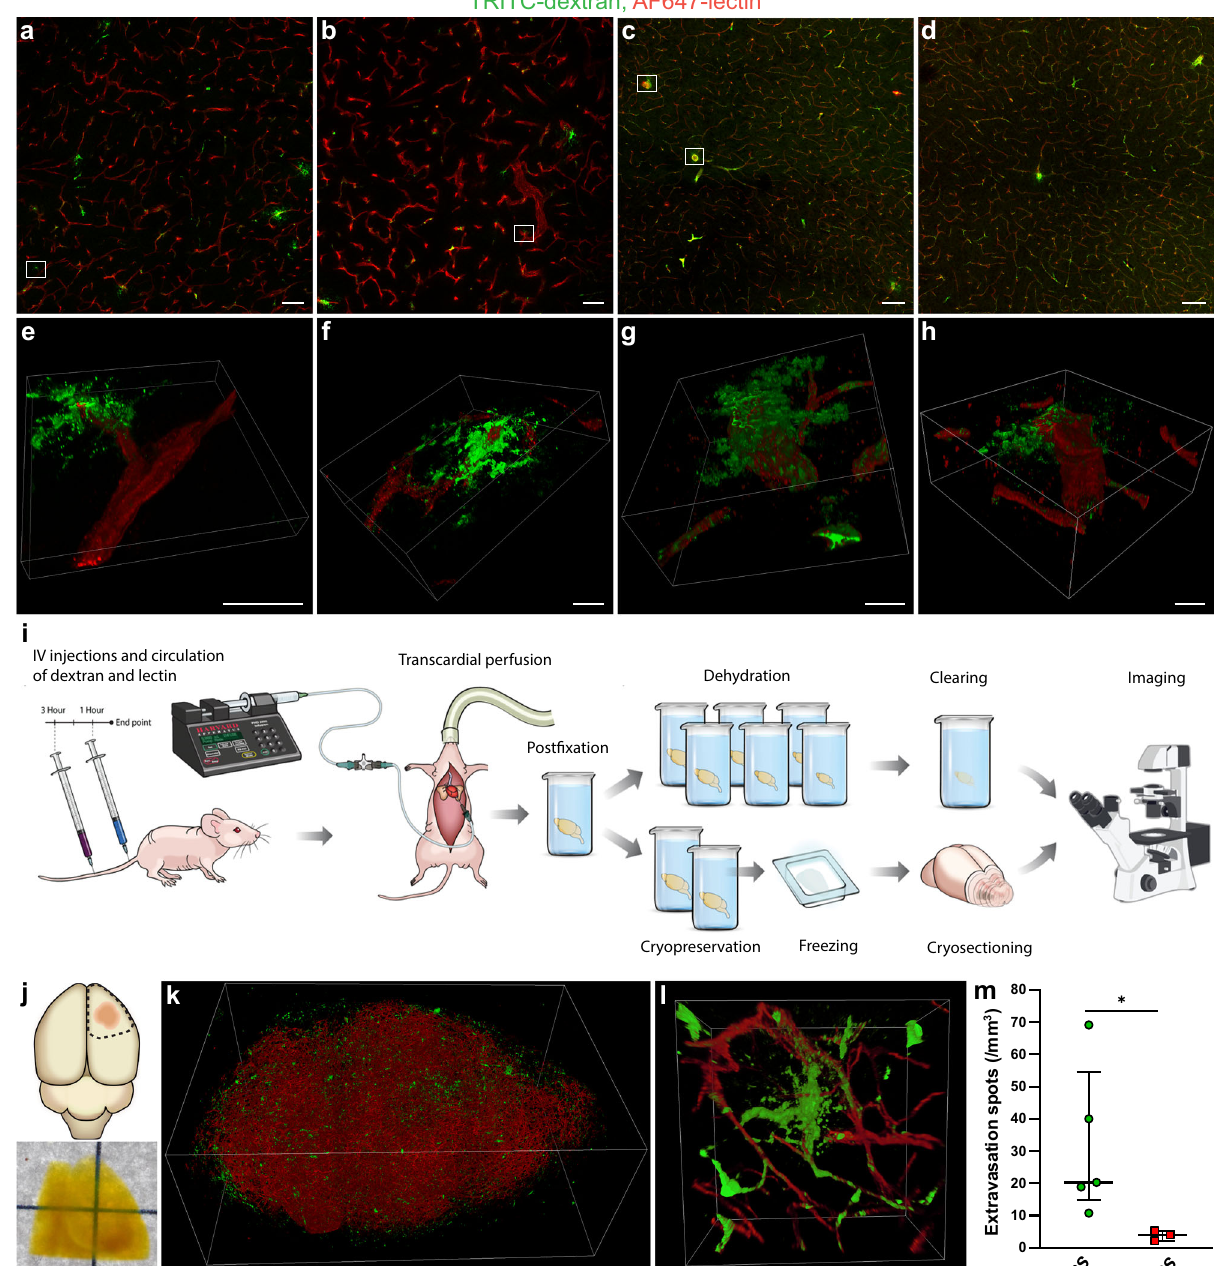
Fig. 4 Comparison of conventional sample preparation versus optical tissue clearing performance for the assessment of compound extravasation in GBM. a , b Confocal images of TRITC-dextran extravasation in GBM. c , d Confocal images of TRITC-dextran extravasation in tumor-free brain regions. Scale bars, 100 µ m. e , f 3D rendering of high-magni fi cation confocal Z -stacks of the regions marked in a and b , illustrating extravasation spots being located in